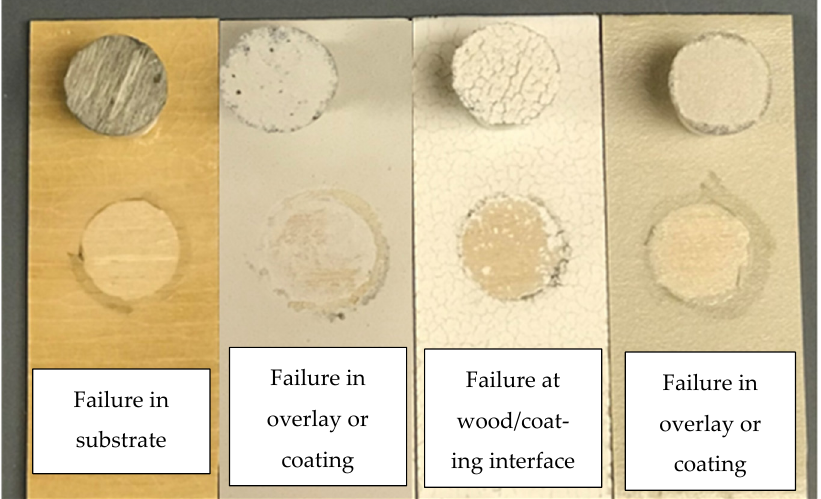
Figure 6. The pull-off strength results for the tested coating systems.